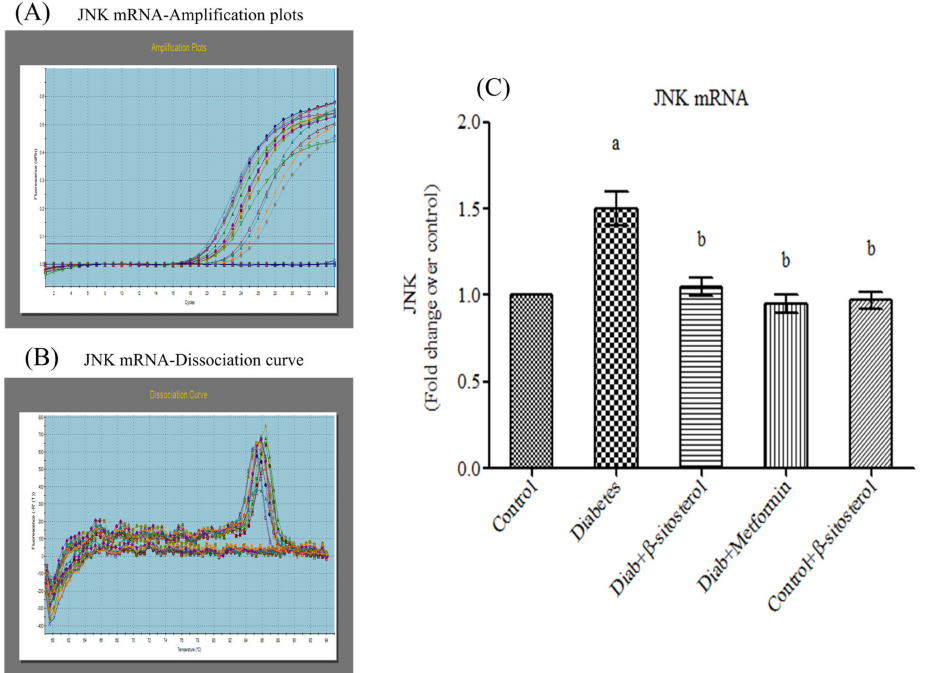
Figure 9. Effect of SIT on mRNA expression of JNK in adipose tissue of type-2 diabetic rats. The mRNA expression of JNK was assessed by real time-PCR. ( A ): Amplification plots; ( B ): dissociation curve analysis confirms the single product of JNK mRNA and ( C ): mRNA expression is given in fold change. Each bar represents mean ± SEM ( n = 6). Significance at p < 0.05. a Significantly different from the control group and b significantly different from the diabetic